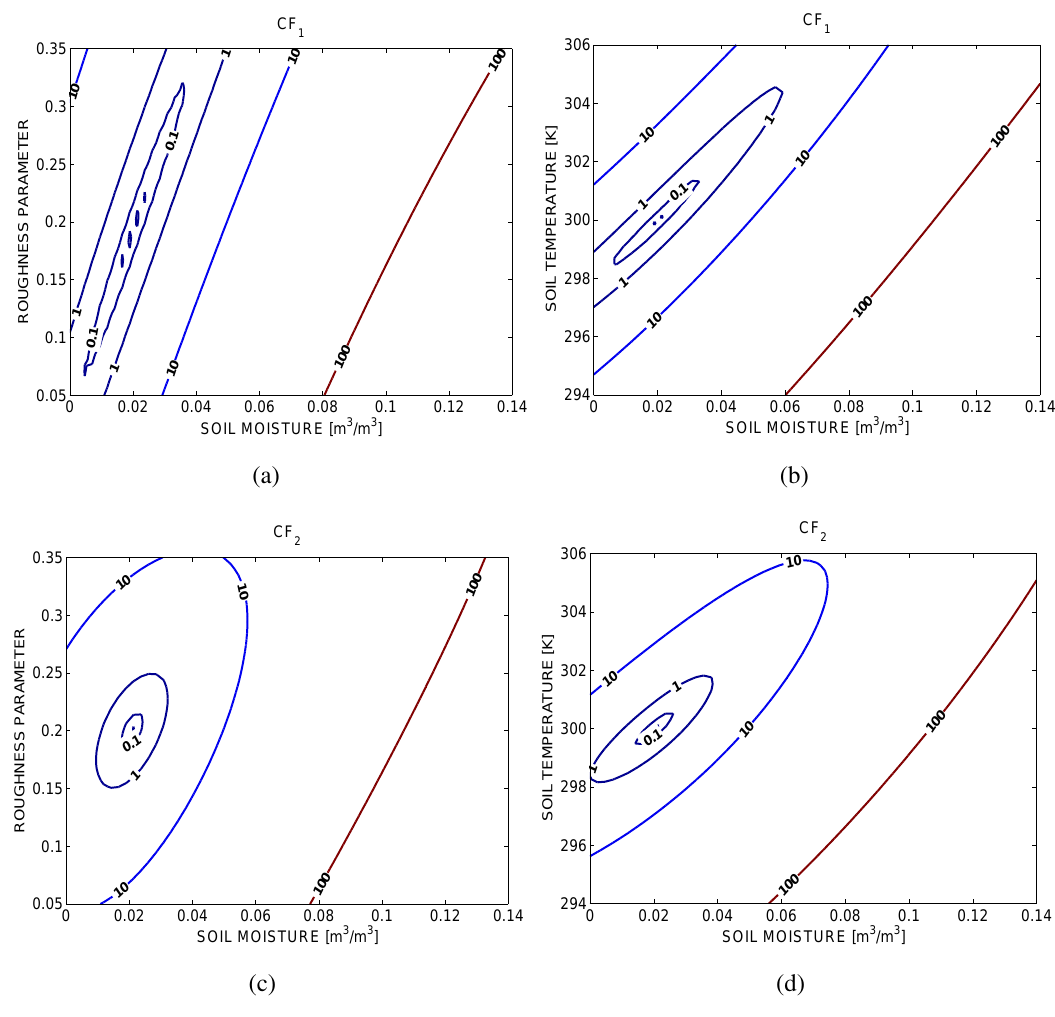
over a vegetation-covered dry I (a) and T vs s (b), with no constraints m s m ). Contours of HR vs s (c) and T vs s (d), adding 1 m s m ( CF m 2